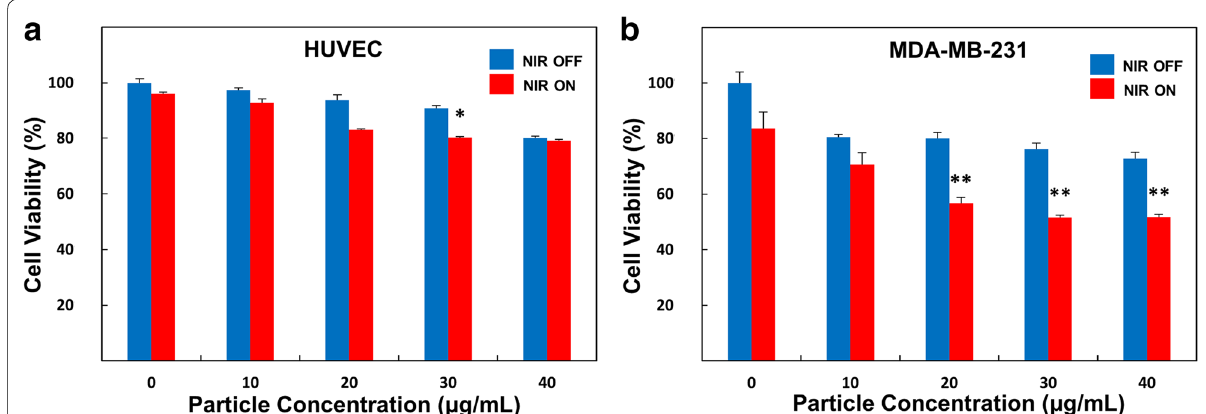
Fig. 4 Analysis of cell viability. Evaluation of cytotoxicity of rGO‑PEG‑FA nanomaterials in HUVECs ( a ) and MDA‑MB‑231 breast cancer cells ( b ) before and after NIR laser treatment (* p < 0.05, ** p <